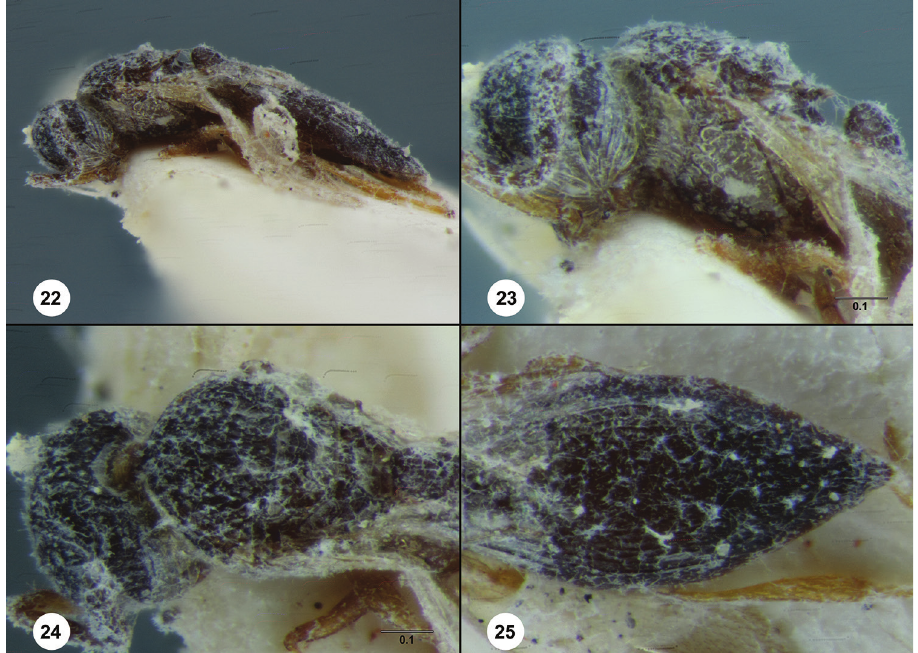
Figures 22–25. Paridris circus (= Paridris coorgensis ), female holotype (IEBR 0106). 22 head, meso- soma, metasoma, lateral view 23 head, mesosoma, T1, lateral view 24 head and mesosoma, dorsal view 25 metasoma, dorsal view. Scale bars in